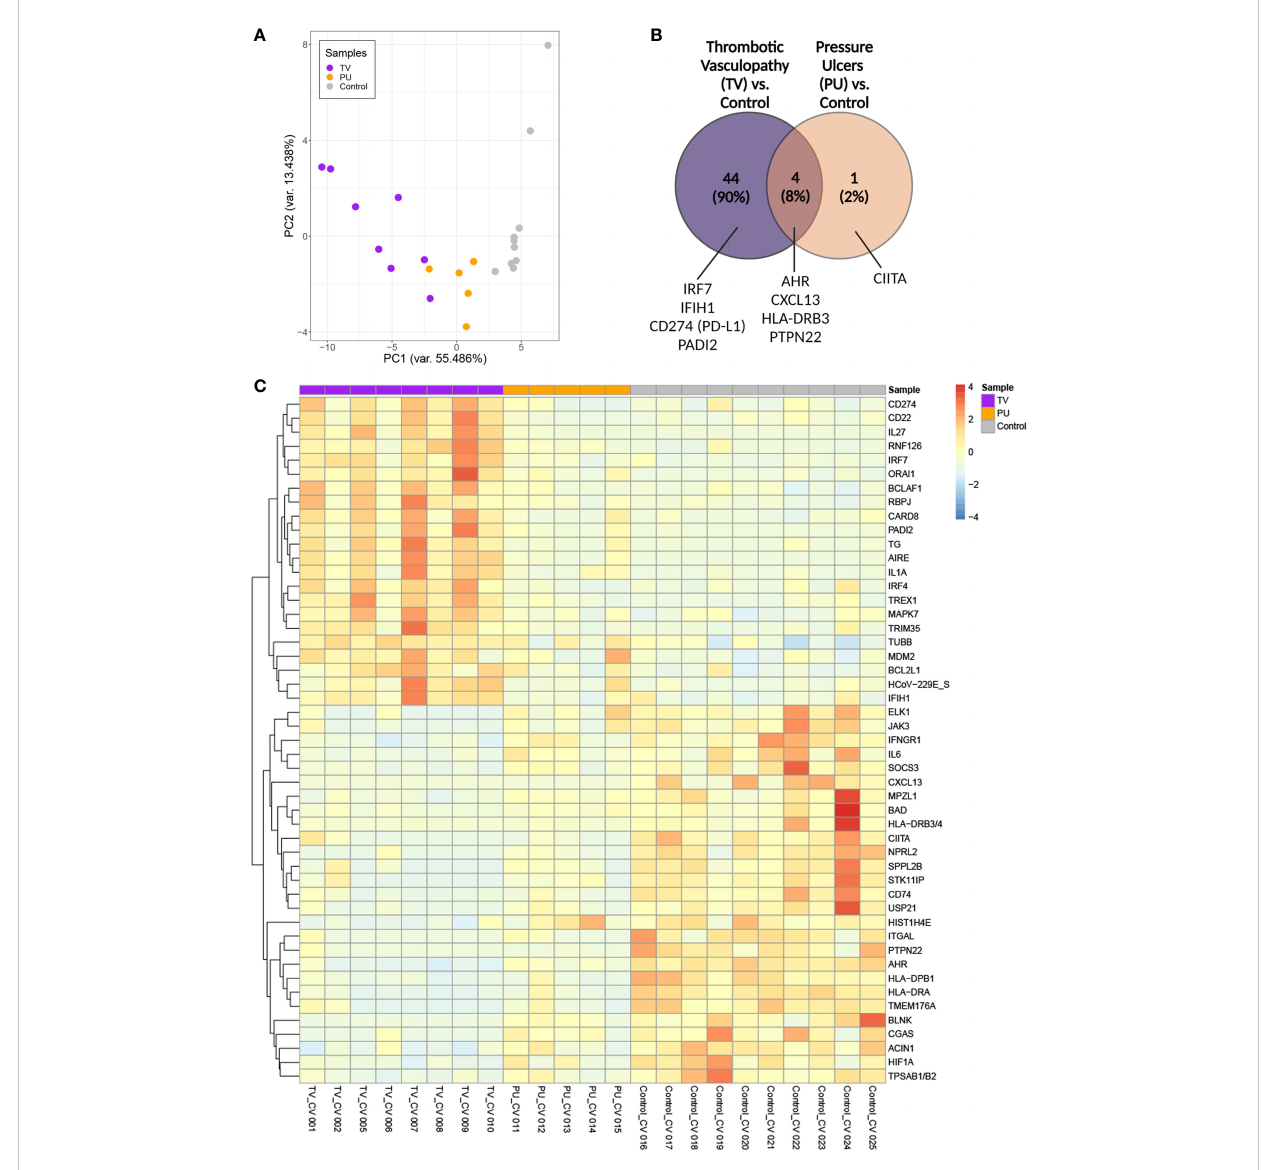
FIGURE 2 Transcriptomic analysis of sacral ulcer biopsies from COVID-19(+) patients reveals distinct signatures between TV and PU groups relative to COVID- 19(-) PU control ulcers. (A) Principal component analysis of all patient samples using normalized counts from the differentially expressed genes with FDR adjusted p -value of < 0.05 indicates the distance between COVID-19(+) TV (TV), COVID-19(+) PU (PU), and COVID-19(-) PU (Control) samples. (B) Venn diagram showing differentially expressed genes (FDR adjusted p -value of < 0.05) in COVID-19(+) patients with TV and PU compared with COVID-19(-) PU control. Representative genes are indicated. (C) Supervised two-dimensional Hierarchical clustering of the 49 genes whose average normalized counts were signi fi cantly different in COVID-19(+) TV and PU groups compared to COVID-19(-) PU control samples (FDR adjusted p - value of <